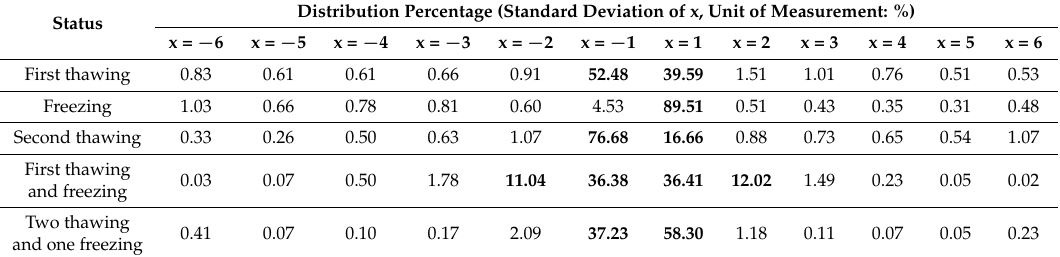
Table 3. Standard deviation distributions for the topographical changes. Distribution percentages greater than 10% are highlighted in